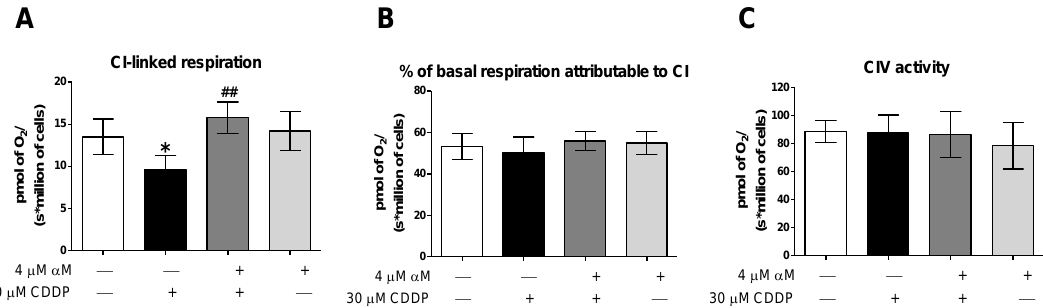
Figure 4. Determination of respiratory parameters at 24 h in LLC-PK1 cells treated with α M, CDDP or both. ( A ) Complex I (CI)-linked respiration, ( B ) percentage of respiration attributable to CI and ( C ) activity of complex IV (CIV). The data are presented as mean ± SD, n = 4–6. * p < 0.05 vs. control. ## p < 0.01 vs. CDDP.